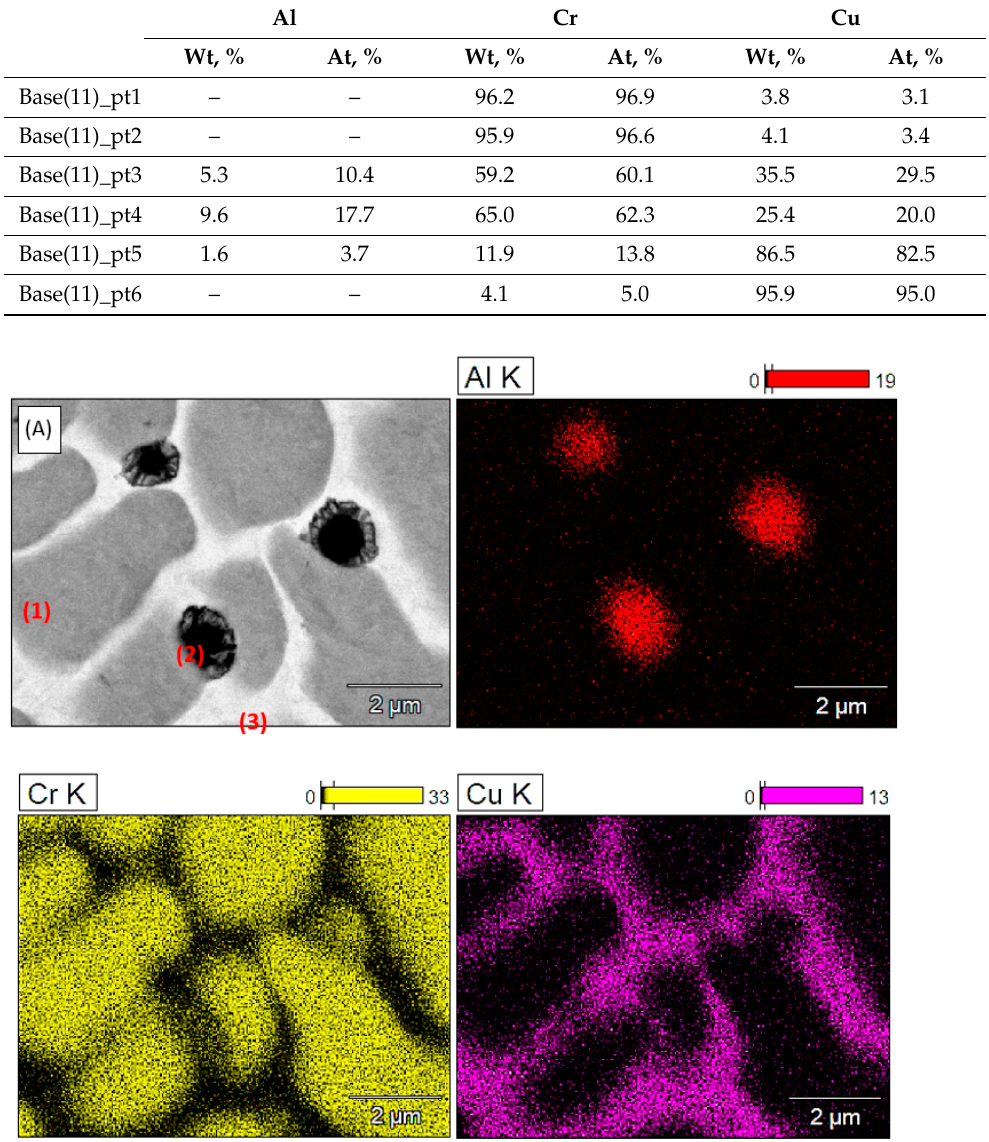
Figure 7. The microstructure of the surface of the top layer after fusion of the CrAl powder into the guide surface of the Cu-ETP copper section insulator; image obtained with the use of secondary electrons (A) and a map of the surface of the distribution of the elements Al, Cr, and Cu. As shown in Figure 9, chromium particles can take both an oval shape (Figure 9a,b) and a shape close to oval with rounded edges (Figure 9c). They can also take the shape of dendrites (Figure 9b). Chromium particles are arranged irregularly in the Cu matrix, which is particularly visible in Figure 9a,b, i.e., for the powder feed rate of 0.2 mm 3 /min; 0.4 mm 3